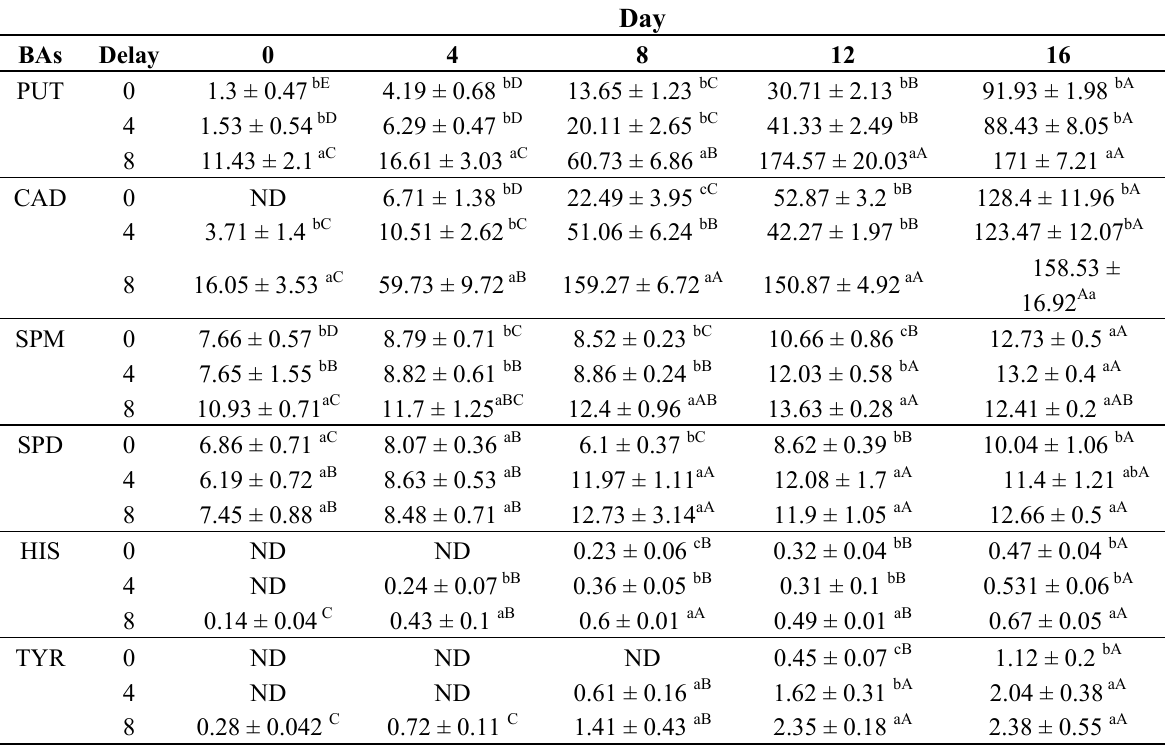
Table 1. Changes in biogenic amines contents (mg kg − 1 ) of common carp stored in ice with 0, 4 and 8 h delay before